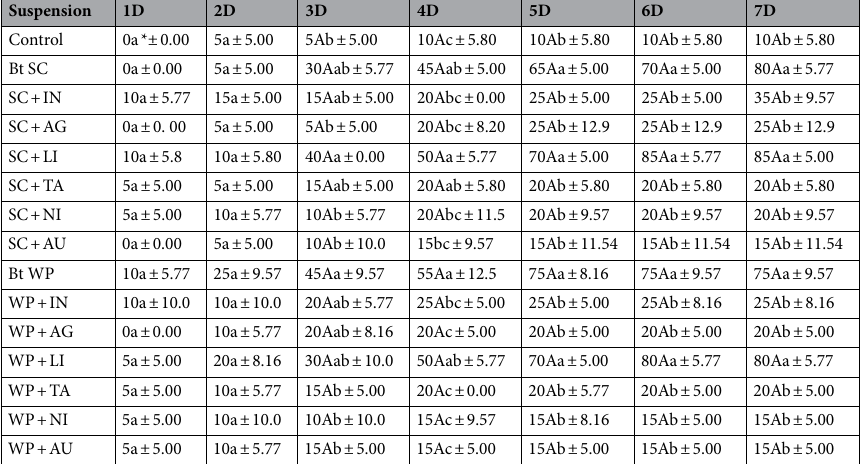
Table 2. Daily percent mortality of Spodoptera frugiperda following treatment with adjuvant mixtures and Bt biopesticides in Dipel SC and Dipel WP formulations. *Means followed by the same letter are not different at